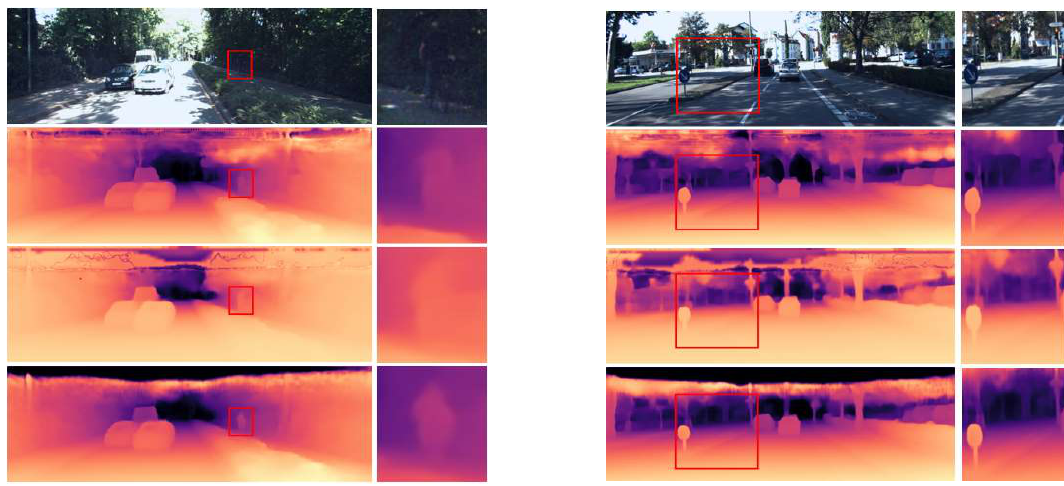
Figure 6. Predicted depth map on the KITTI Eigen split. Detailed comparison from top to bottom: original RGB, BTS, Lapdepth, and ours.